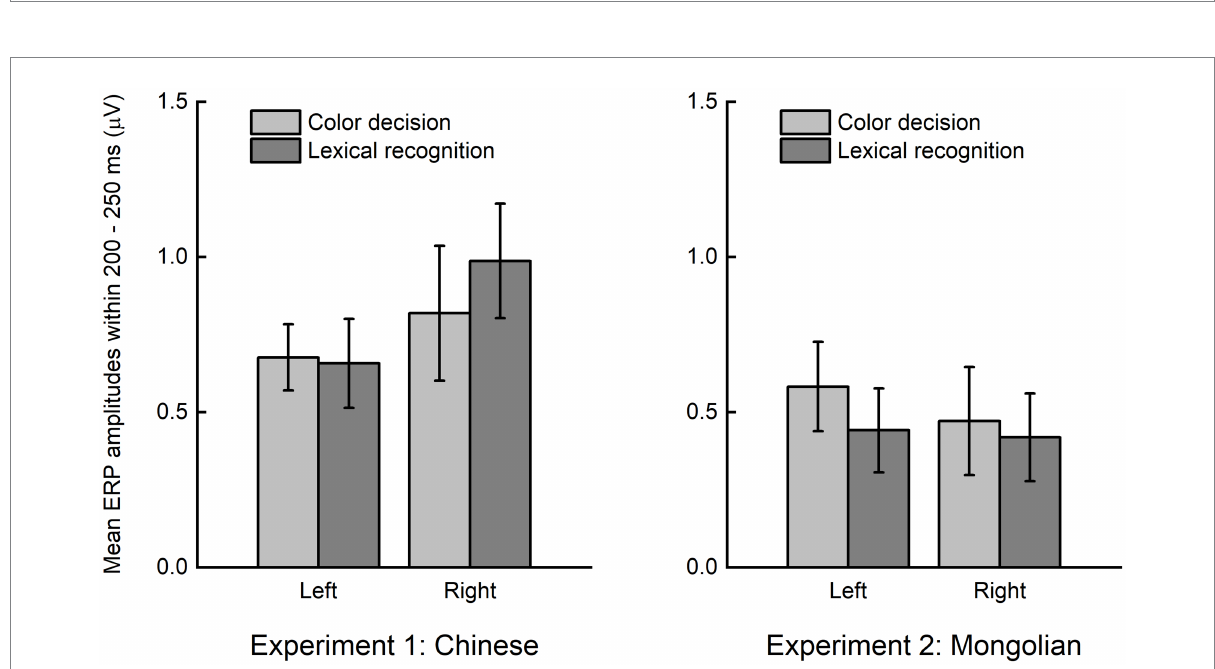
FIGURE 6 Lexical effect around 200–250 ms. The early lexical effects were not significantly modulated by the factors of “task” (color decision and lexical recognition) and “hemisphere” (left and right), but significantly different between Experiment 1 (Chinese) and Experiment 2